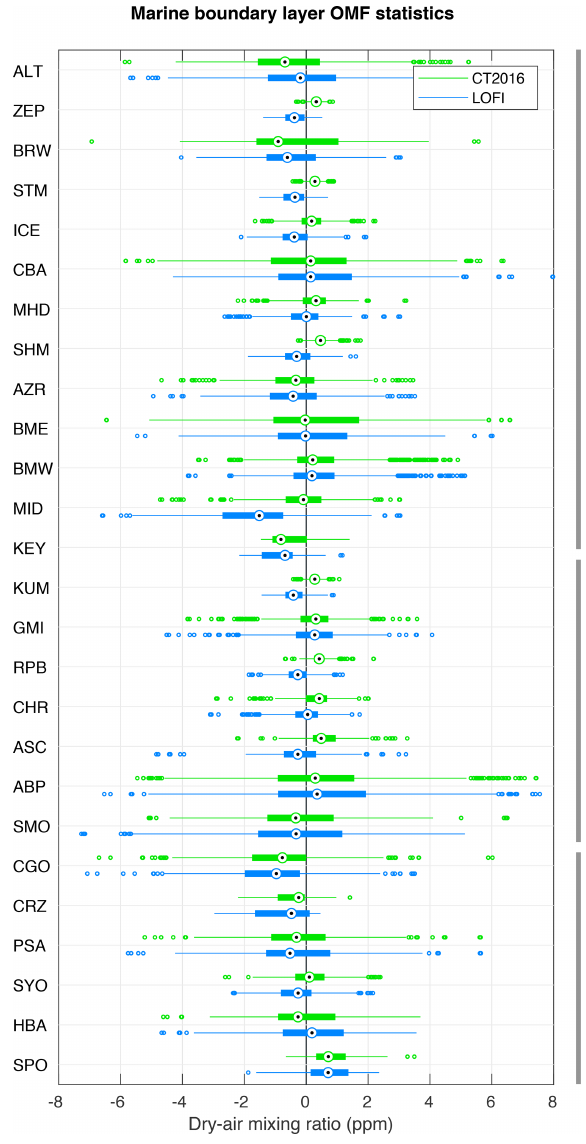
Figure 4. Box-and-whisker plots of observation minus forecast (OMF) statistics for 2003–2015 from model simulations using CT2016 fluxes (green) and using LoFI fluxes (blue). The compar- ison sites are all of the stations from the marine boundary layer collection and are ordered by latitude along the y axis. For each site, the circular target denotes the median, the solid box denotes the range between the 25th and 75th percentiles, whiskers denote a range of roughly 99% of the data, and boxes denote values outside this range. Grey bars on the right indicate, from top to bottom, the northern extratropics (north of 23 ◦ N), tropics (between 23 ◦ N and 23 ◦ S), and southern extratropics (south of 23 ◦